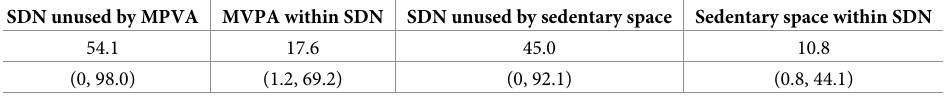
Table 4. Amount of space used between self-drawn neighbourhoods and MVPA space and sedentary